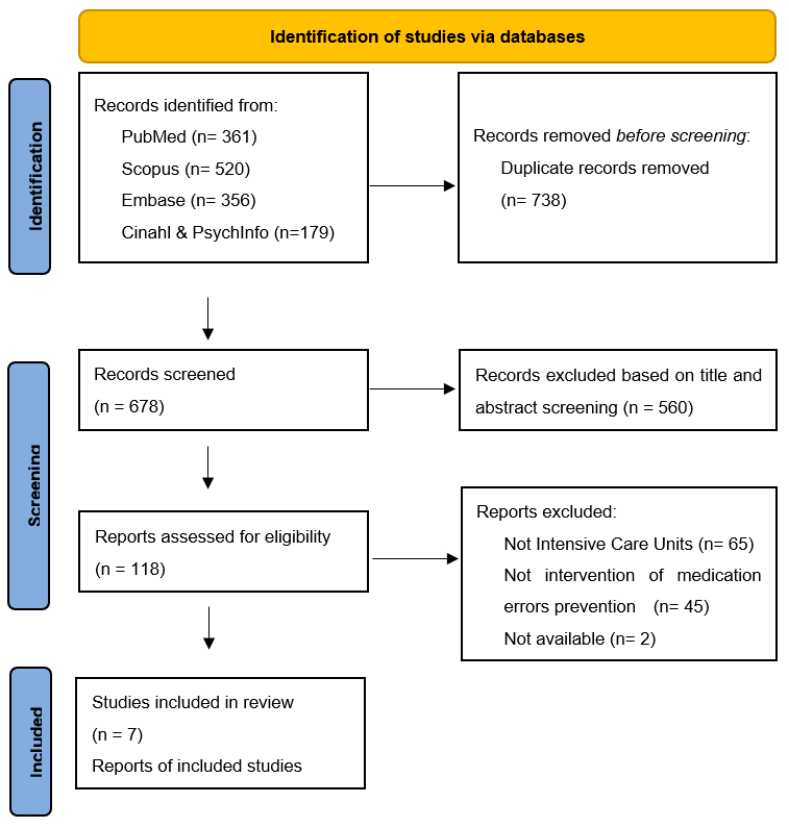
Figure 1. Flow diagram of the search and selection process, based on the PRISMA flowchart. From [25].